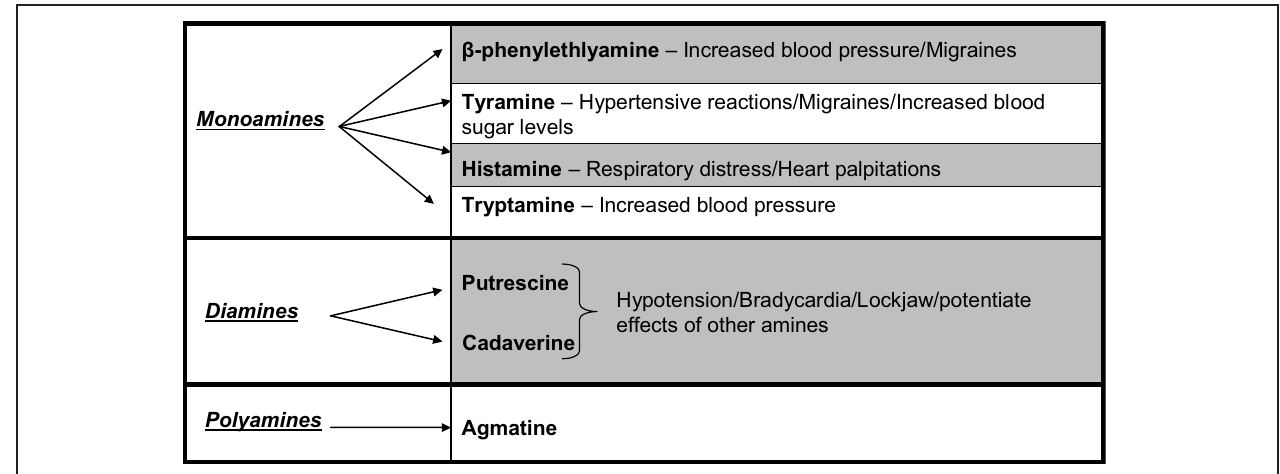
FIGURE 1 | Food associated amines and their